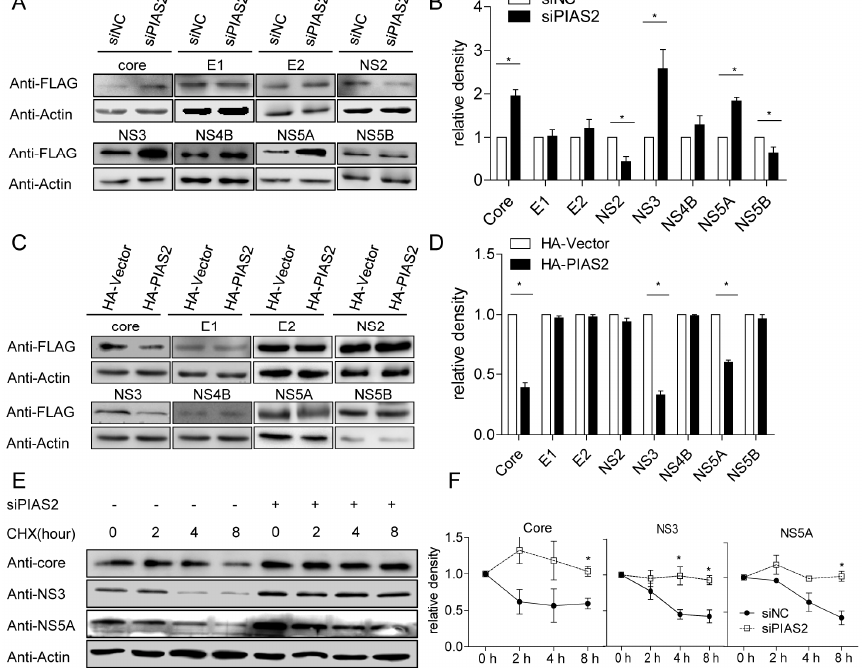
Figure 4. PIAS2 modulates the stability of the HCV core, NS3 and NS5A proteins. ( A , B ) 293T cells were transfected with siNC or siPIAS2 and then transfected with the indicated HCV protein expression plasmids. The expression levels of the HCV proteins were detected at 48 h post-transfection. The relative density of the blots from three independent experiments were analyzed by densitometry and shown in panel ( B ); ( C , D ) 293T cells were transfected with pHA-Vector or pHA-PIAS2, HCV protein expression plasmids, and pCer-SUMO1. The HCV protein expression levels were detected at 48 h post-transfection. The relative density of the blots from three independent experiments was analyzed by densitometry and shown in panel ( D ); ( E ) Huh7 cells were transfected with siNC or siPIAS2 and then infected with J399EM at an MOI of 0.1 for 72 h. The cells were treated with cycloheximide (CHX) (100 μ g/mL), and protein samples were collected at the indicated time points to evaluate the protein expression levels as indicated; ( F ) the relative density of the blots from three independent experiments was analyzed by densitometry and normalized to actin. To show the degradation rate, the samples without CHX treatment in each group were set to 1, * p < 0.05.